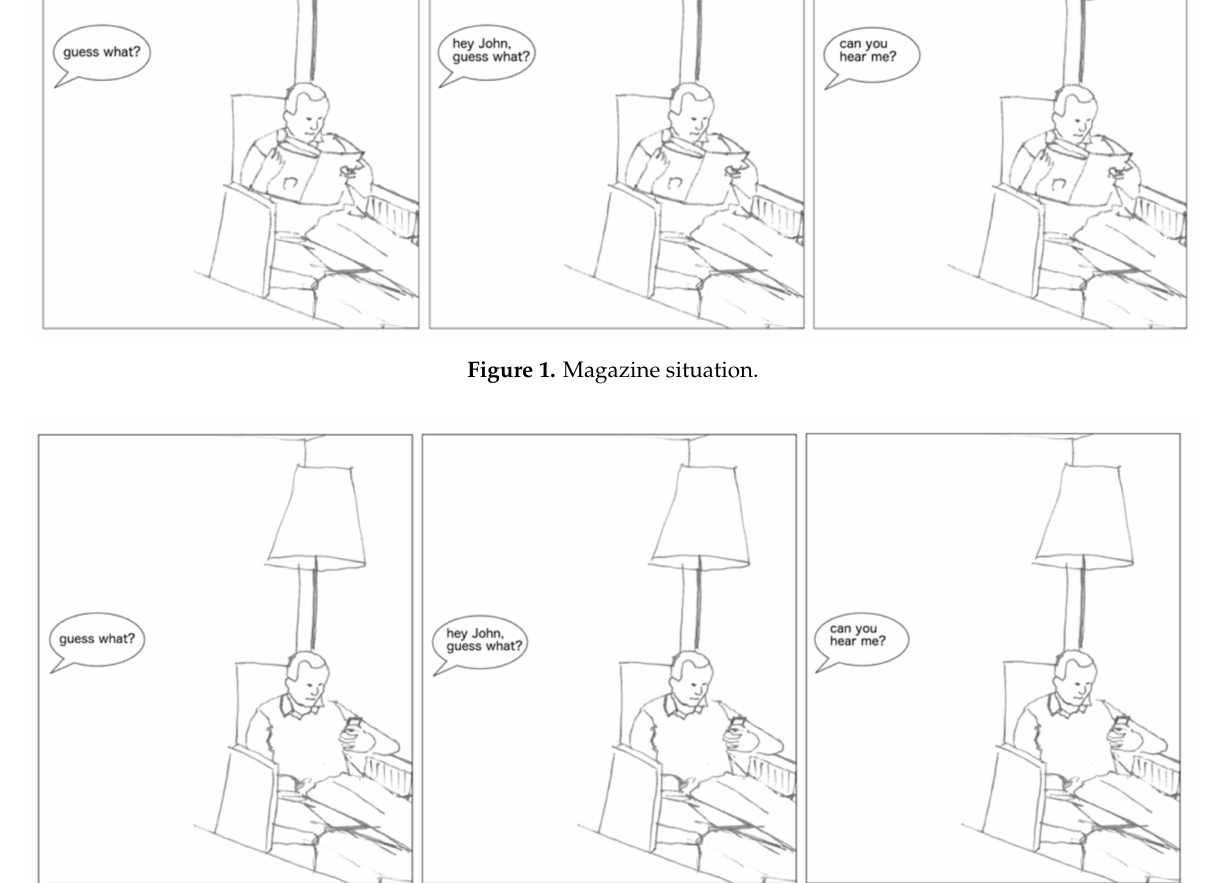
Figure 2. Smartphone